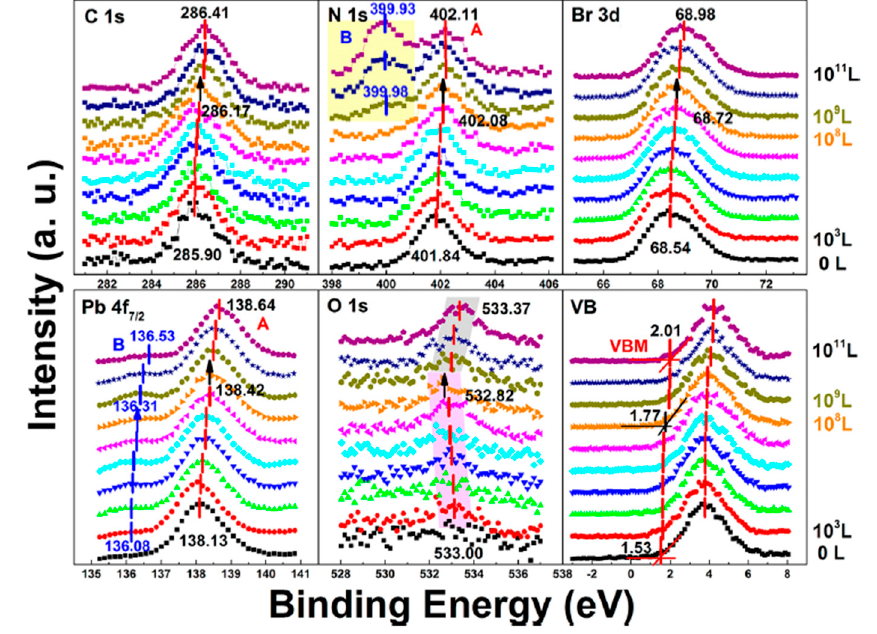
Figure 10. Evolution of C 1s, N 1s, Br 3d, Pb 4f 7/2 , O 1s, and the VB region of cleaved MAPbBr 3 single crystal under water exposure from 0 to 10 11 L. From Ref. [38] with permission.